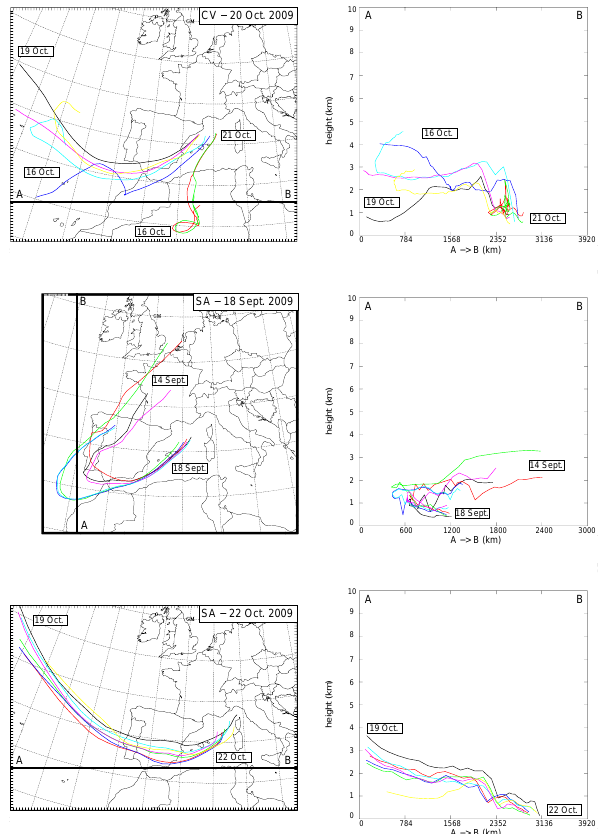
Fig. 15. Same as Fig. 13, but for the last CV case, the 20 October 2009 (top), and both SA cases, the 18 September 2009 (middle) and the 22 October 2009 (bottom). The backward trajectories of the 20 October 2009 and 22 October 2009 cases are performed with the RAI40 simulation.